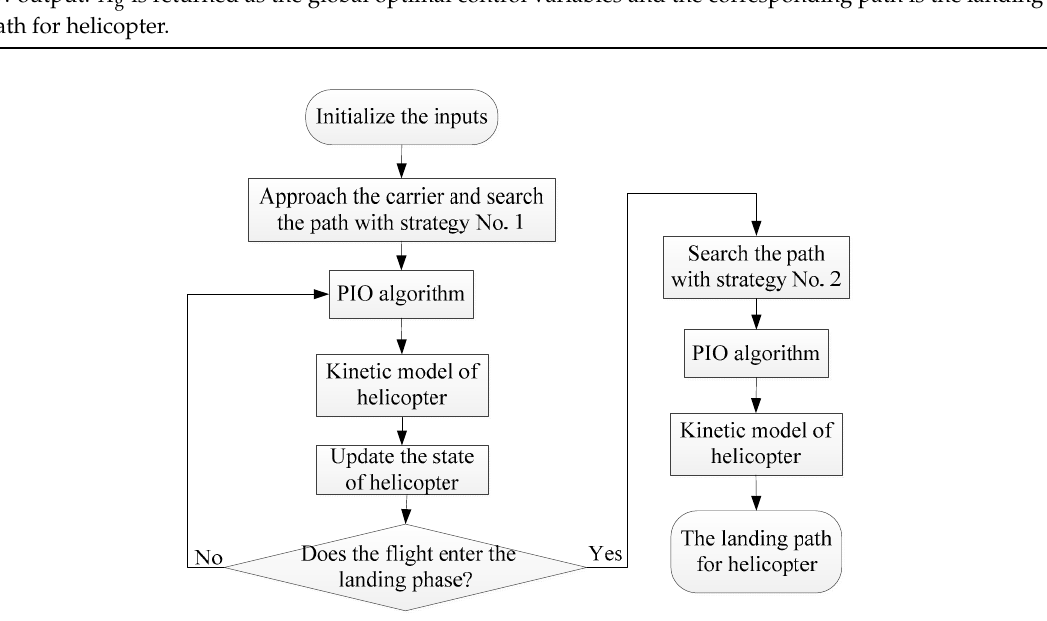
Figure 4. The flow of path planning algorithm.